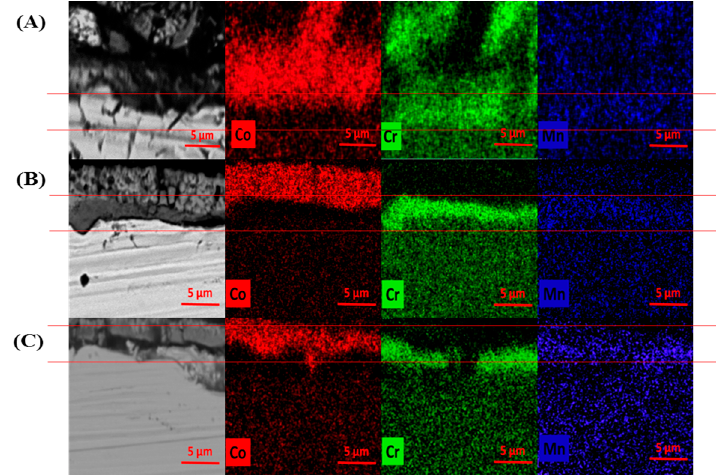
Figure 8. SEM enlarged images and chemical cross-section composition maps for samples ( A ) A1; ( B ) A2; ( C ) A3, after oxidation heat treatment at 800 °C for 300 h.